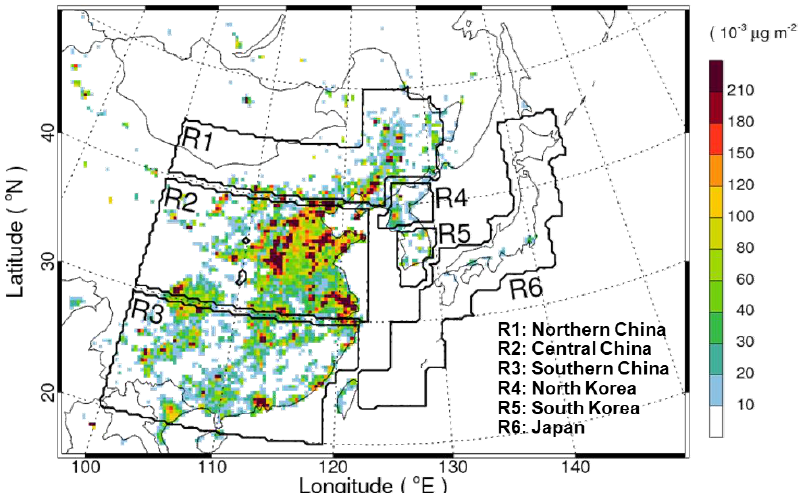
Figure 1. Simulation domain of the Weather Research and Forecasting-Chemistry (WRF-Chem) and Weather Research Forecasting/Community Multiscale Air Quality modeling system (WRF/CMAQ) models. Six subdivisions are defined for performance comparison. R1: Northern China, R2: Central China, R3: Southern China, R4: North Korea, R5: South Korea, R6: Japan.